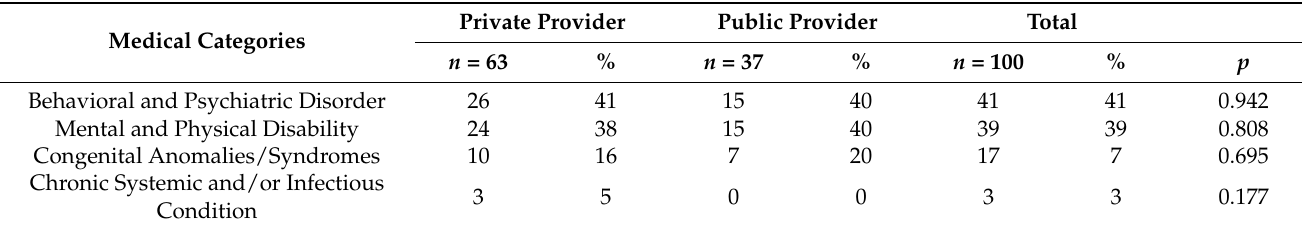
Table 3. Sample distribution according to the medical condition categories and International Associa- tion of Disability and Oral Health classification.